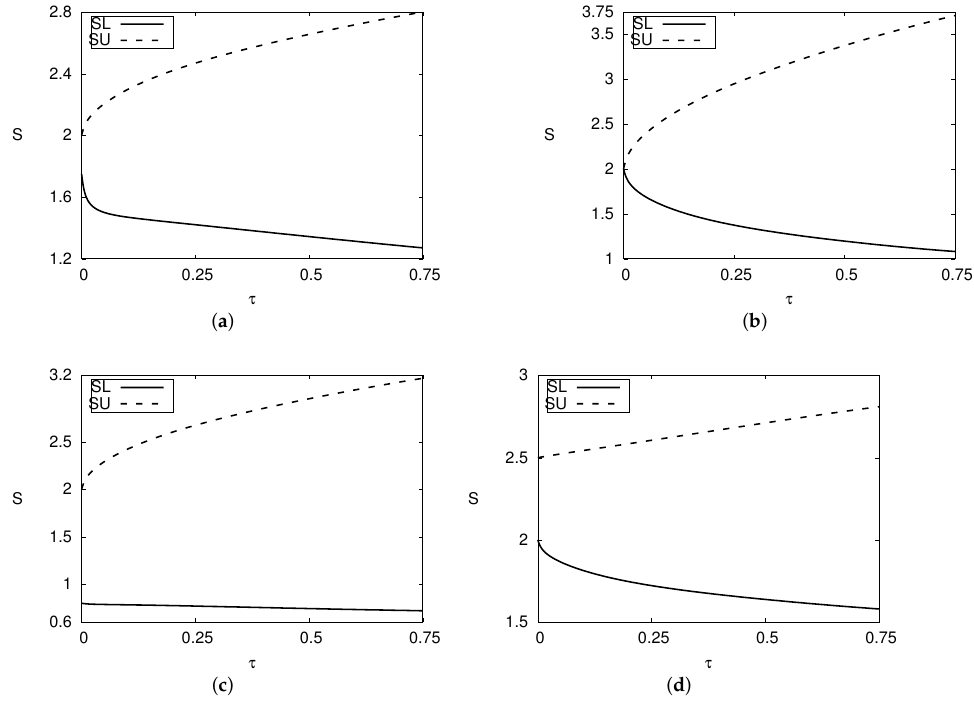
Figure 2. Optimal exercise stock prices for 0 ≤ τ ≤ 9 ( b ) σ = 0.3, r = 0.02, q = 0.02, ( c ) σ = 0.3, r = 0.02, q = 0.05 and ( d ) σ = 0.15, r = 0.05, q =